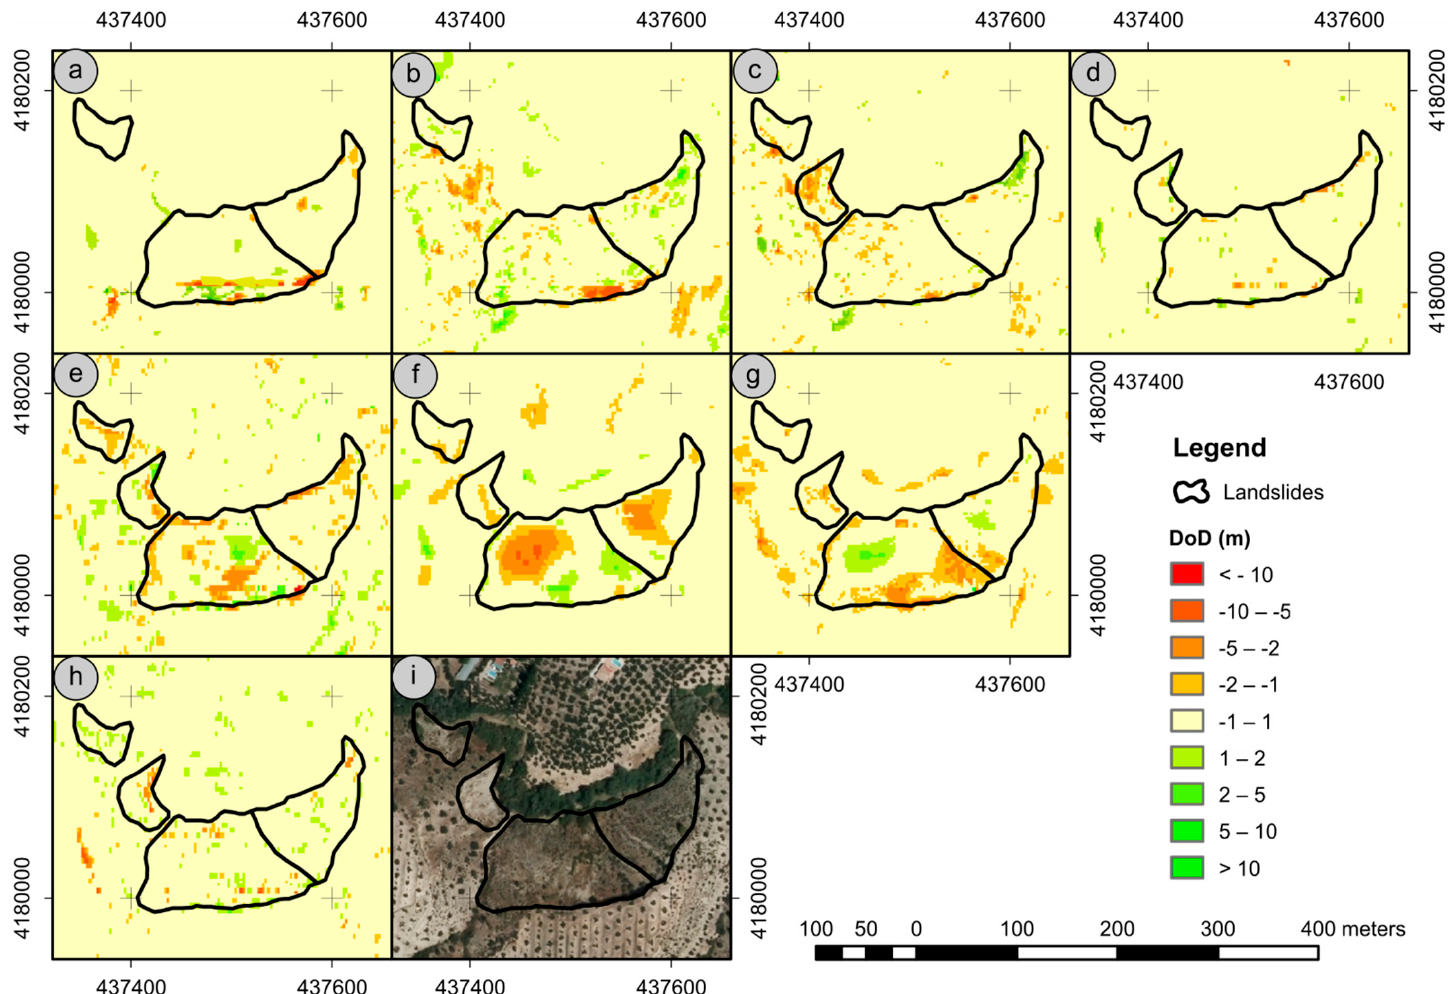
Figure 7. DoDs of the area 1: ( a ) 1984–1996; ( b ) 1996–2001; ( c ) 2001–2005; ( d ) 2005–2009; ( e ) 2009–2010; ( f ) 2010–2011; ( g ) 2011–2013; ( h ) 2013–2016; ( i ) orthoimage (2016). Coordinates are in ETRS89-UTM30. Location of area 1 is shown in Figure